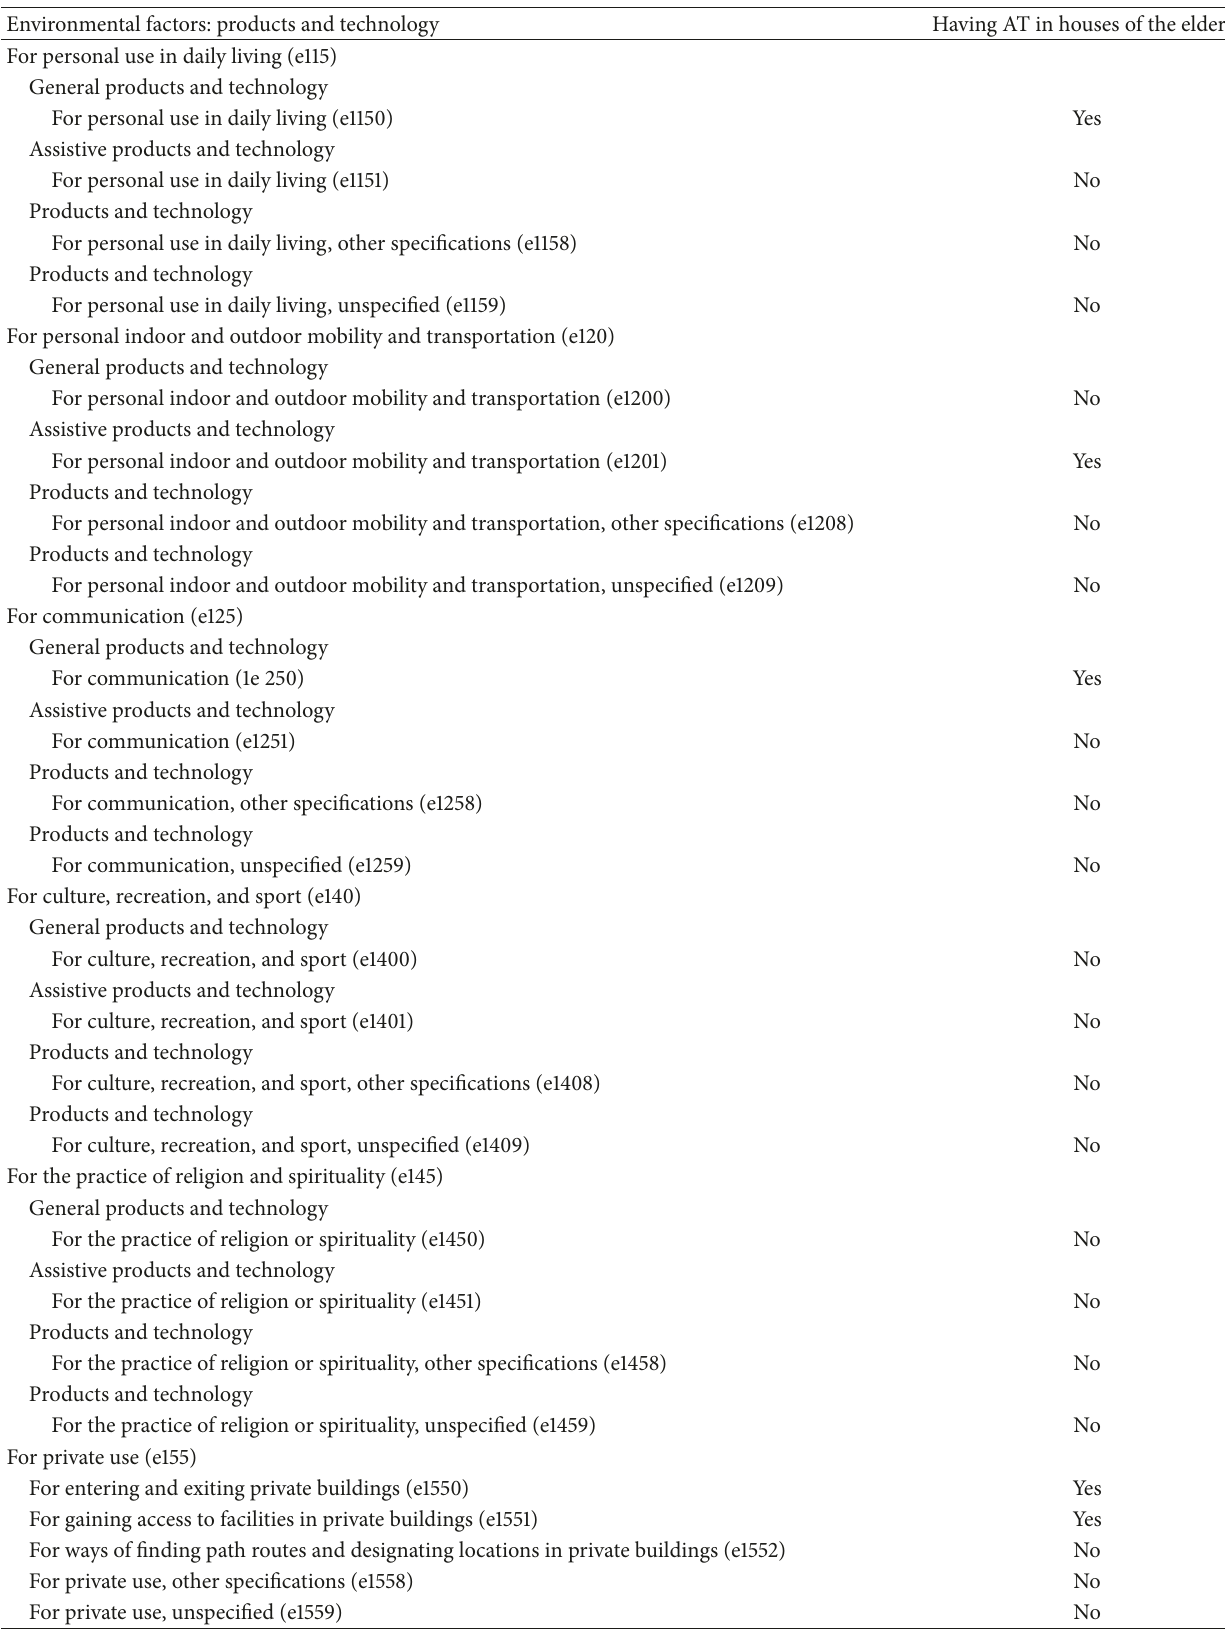
Table 5: AT in houses of the home-bound